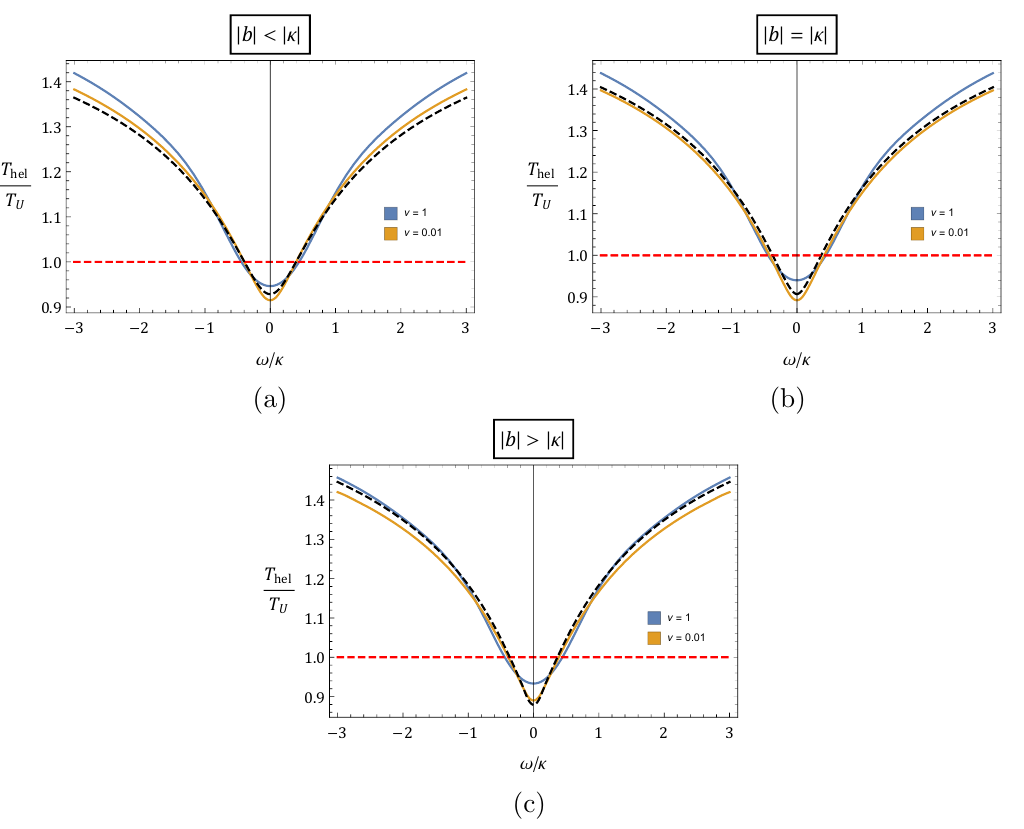
Figure 7 . E(cid:11)ective temperatures along the Hypertor (helix) worldline. The Unruh temperature, T U , is indicated by a red dotted line. For j b j < j (cid:20) j , the Infrator (catenary) temperature, T cat , is indicated by a black dotted line. For j b j = j (cid:20) j , the Parator (cusped) motion temperature, T cus , is indicated by a black dotted line. For j b j > j (cid:20) j , the Ultrator (circular) motion temperature, T cus , is indicated by a black dotted line. In each case, at small hypertorsion the Hypertor temperature curve asymptote the black dotted